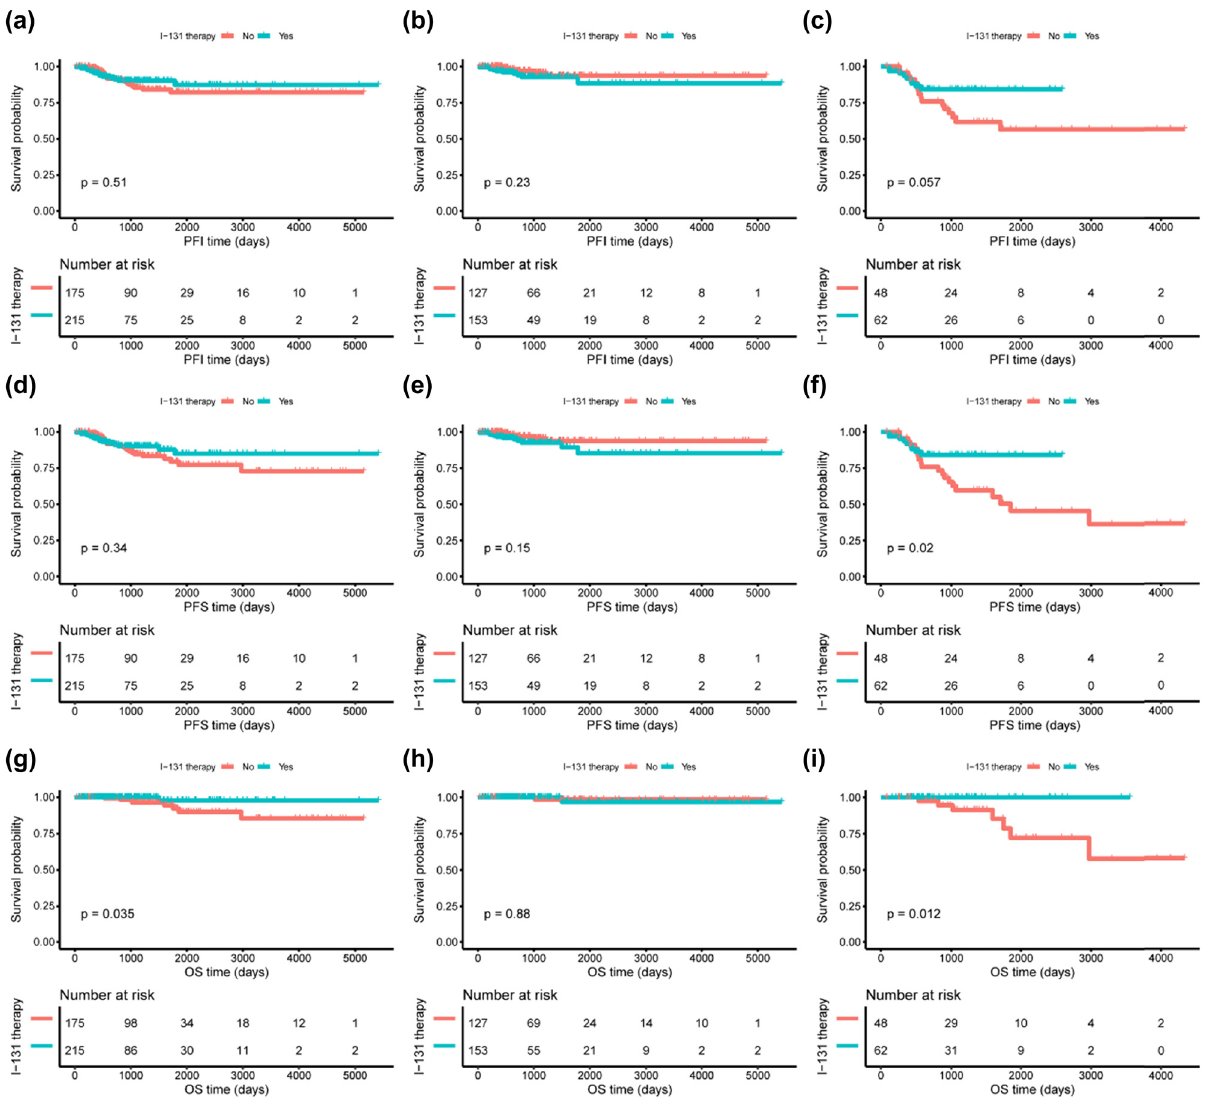
Figure 9: Comparisons of PFI, PFS, and OS between PTC patients with and without postoperative I - 131 therapy in whole cohort or subgroups strati fi ed by the risk scores. ( a – c ) E ff ects of I - 131 therapy on PFI in the whole cohort ( a ) , unfavorable subgroup ( b ) , and favorable subgroup ( c ) . ( d – f ) E ff ects of I - 131 therapy on PFS in the whole cohort ( d ) , unfavorable subgroup ( e ) , and favorable subgroup ( f ) . ( g – i ) E ff ects of I - 131 therapy on OS in the whole cohort ( g ) , unfavorable subgroup ( h ) , and favorable subgroup ( i ) results from TCGA bulk RNA sequencing ( Figure S1 ) . The AE000661.50 were mainly expressed in state 3 cells ( Figure thyroid cells could be further clustered into nine sub - groups, which included three developmental hierarchies ( State 1 – 3 ) based on the cell markers derived from trajectory analysis in the previous report [ 27 ] . State 1 indicated the normal thyroid cells, state 2 indicated the premalignant cells, and state 3 indicated the malignant cells. Thyroid cells in adjacent normal samples were all with states 1 and 2 whereas cells with state 3 were enriched in the tumor, LN, and distance metastasis samples ( Figure 11d ) . CTA - 398F10.2, RP4 - 794H19.1, and RP11 - 677M14.3 were mainly expressed in states 1 and 2 cells while RP11 - 60L3.1, RP11 - 20J15.3, and